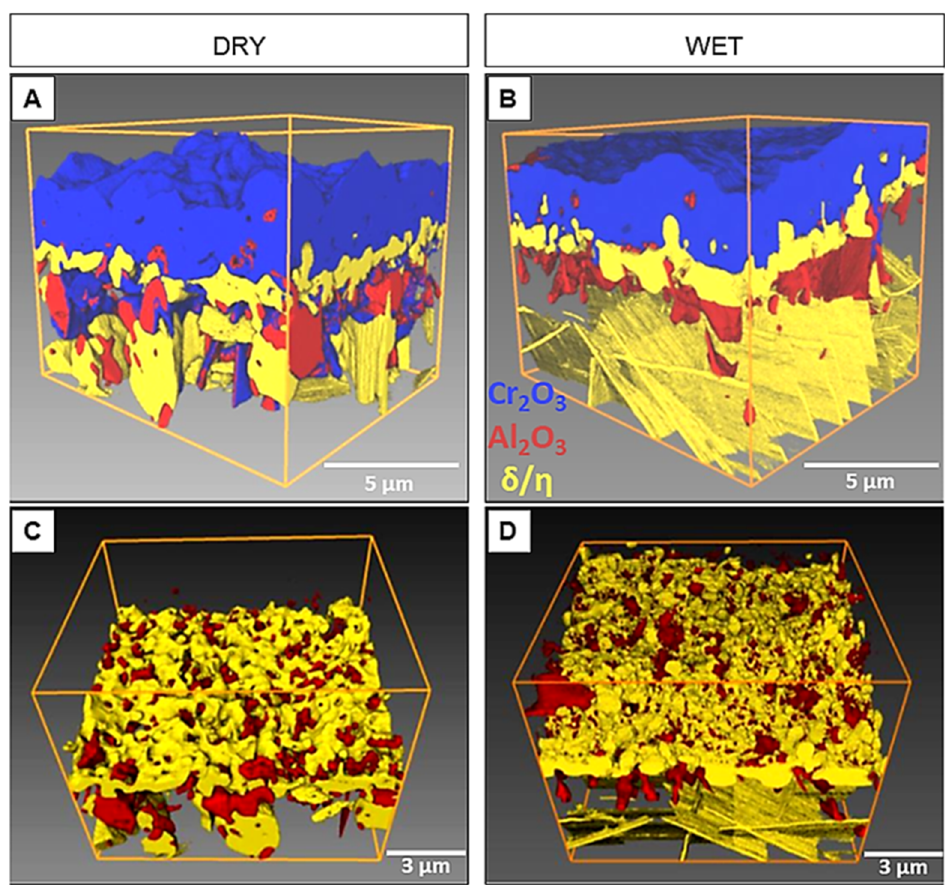
Figure 7. The 3D visualization of the oxide scale formed on the 718Plus superalloy after oxidation at 850 °C for 120 h in dry ( A ) and wet ( B ) air, rendered via tomographic reconstruction; microstructural features of individual components: Al2O3, δ and η phases; ( C )—dry air, ( D )—wet air.